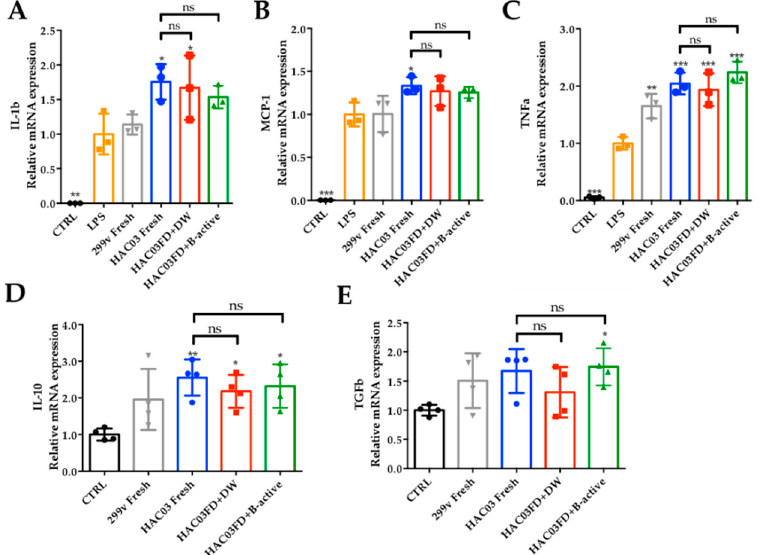
Figure 3. Lp. plantarum HAC03 immunomodulation in a murine macrophage cell line. Pro-inflammatory cytokines ( A ) interleukin 1 beta, ( B ) monocyte chemoattractant protein-1 and ( C ) tumor necrosis factor alpha and anti-inflammatory cytokines, ( D ) interleukin 10, and ( E ) transforming growth factor beta. Relative gene transcription levels (compared to the control) in a mouse macrophage cell line after 16 h stimulation with fresh and freeze-dried HAC03 cultures rehydrated with and without B-active. Fresh cultures were grown overnight on MRS broth at 37 °C, and freeze- dried bacteria were rehydrated with distilled water for 1 min at 25 °C before the test. Macrophages cultivated in DMEM media were used as negative controls (CTRLs), and cells treated with LPS (1 μ g/mL) were used as a positive control. Lp . plantarum 299v was used as a probiotic control strain. Data are expressed as mean ± SD, n = 3. * p < 0.05, ** p < 0.01 and *** p < 0.005. compared to LPS and CTRL; one-way ANOVA, Dunnett’s multiple comparison test.